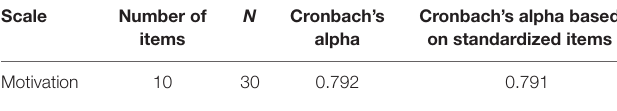
TABLE 3 | The reliability index for the motivation